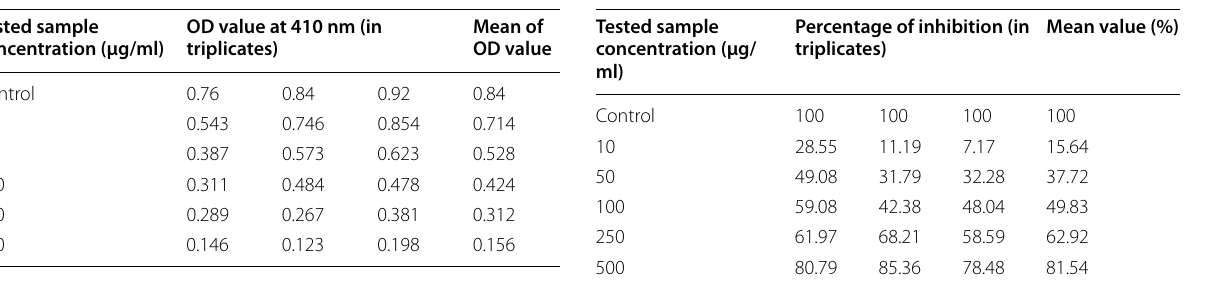
Table 6 Percentage inhibition of AchE in